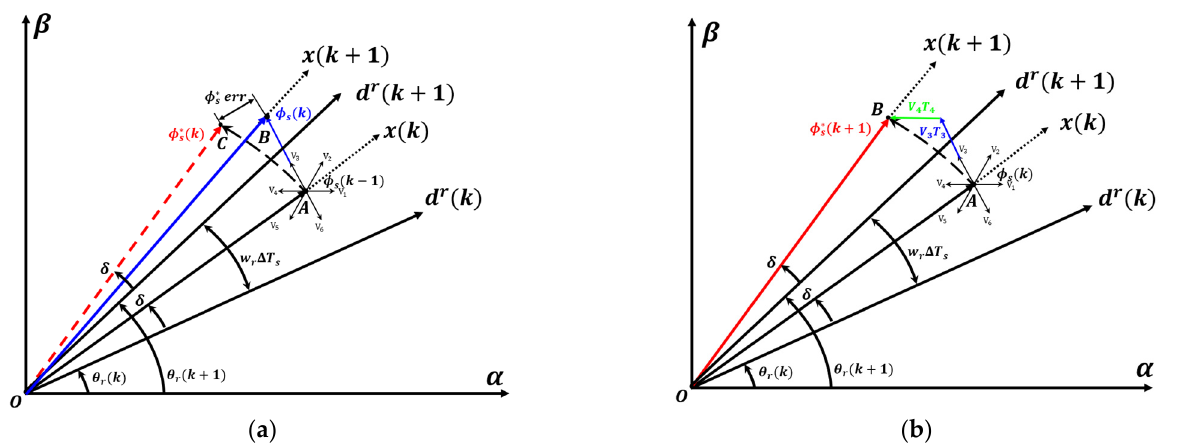
Figure 4. Stator linkage flux vector trajectory according to voltage vector command under DTC-SVM control ( a ) Position of stator flux in the case of conventional DTC control ( b ) Position of stator flux in the case of DTC-SVM control.